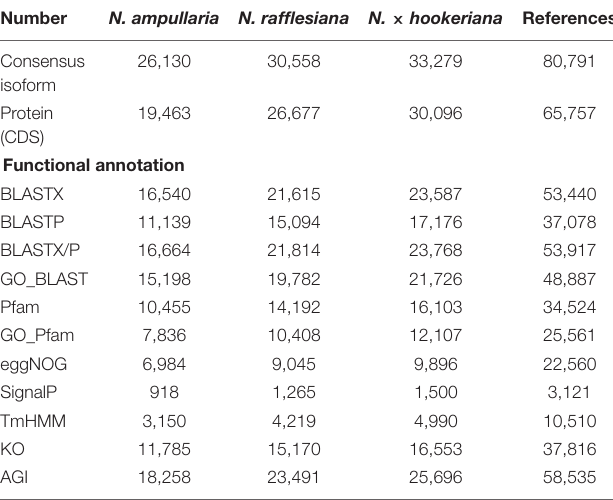
TABLE 1 | Functional annotation of Nepenthes transcriptomes using Trinotate